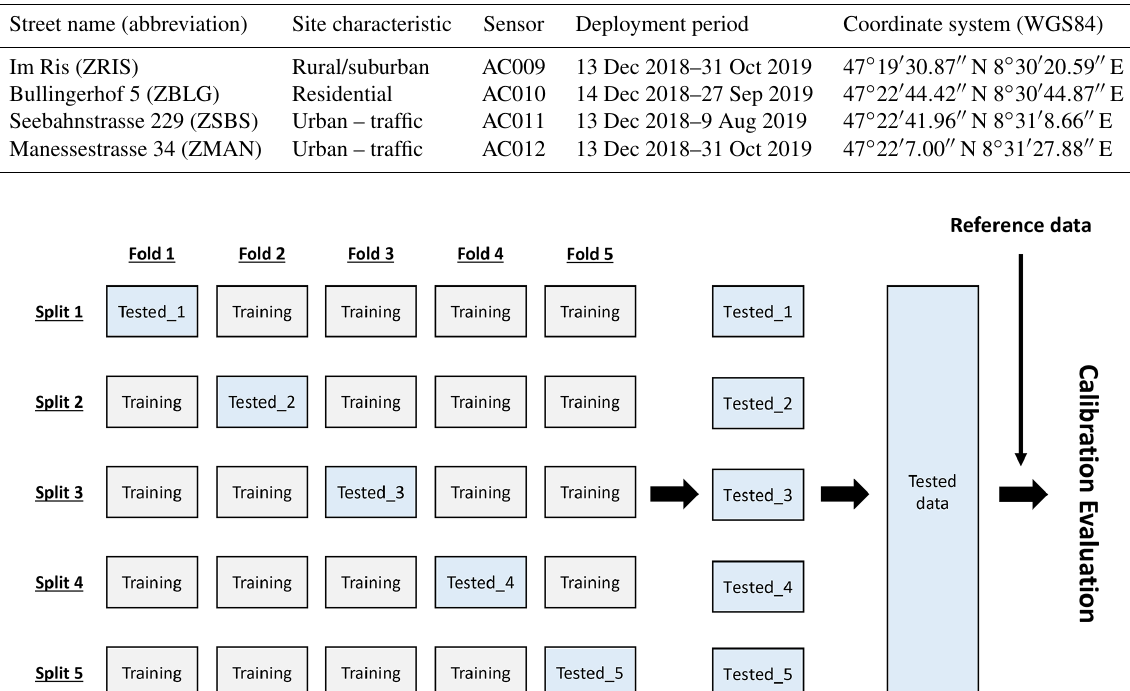
the method can not adequately predict values that are be- yond the range of the training data set (Malings et al.,